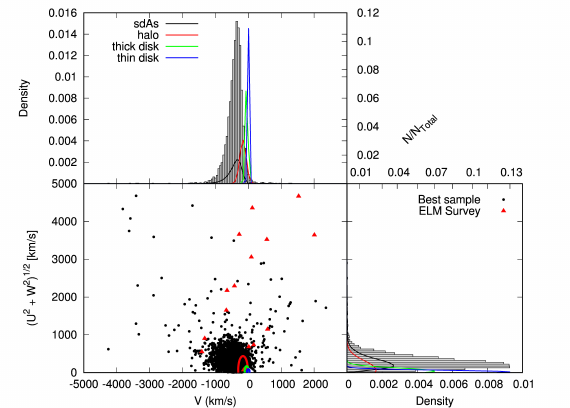
Figure 6. Toomre diagram of the objects in our sample, assuming a main sequence radius. The velocities the objects in the ELM survey would have if main sequence radii were assumed are shown for comparison. Density plots are shown to left and on top. The ellipses indicate the 3- σ values for halo (red), thick disk (green) and thin disk (blue) according to Kordopatis et al.